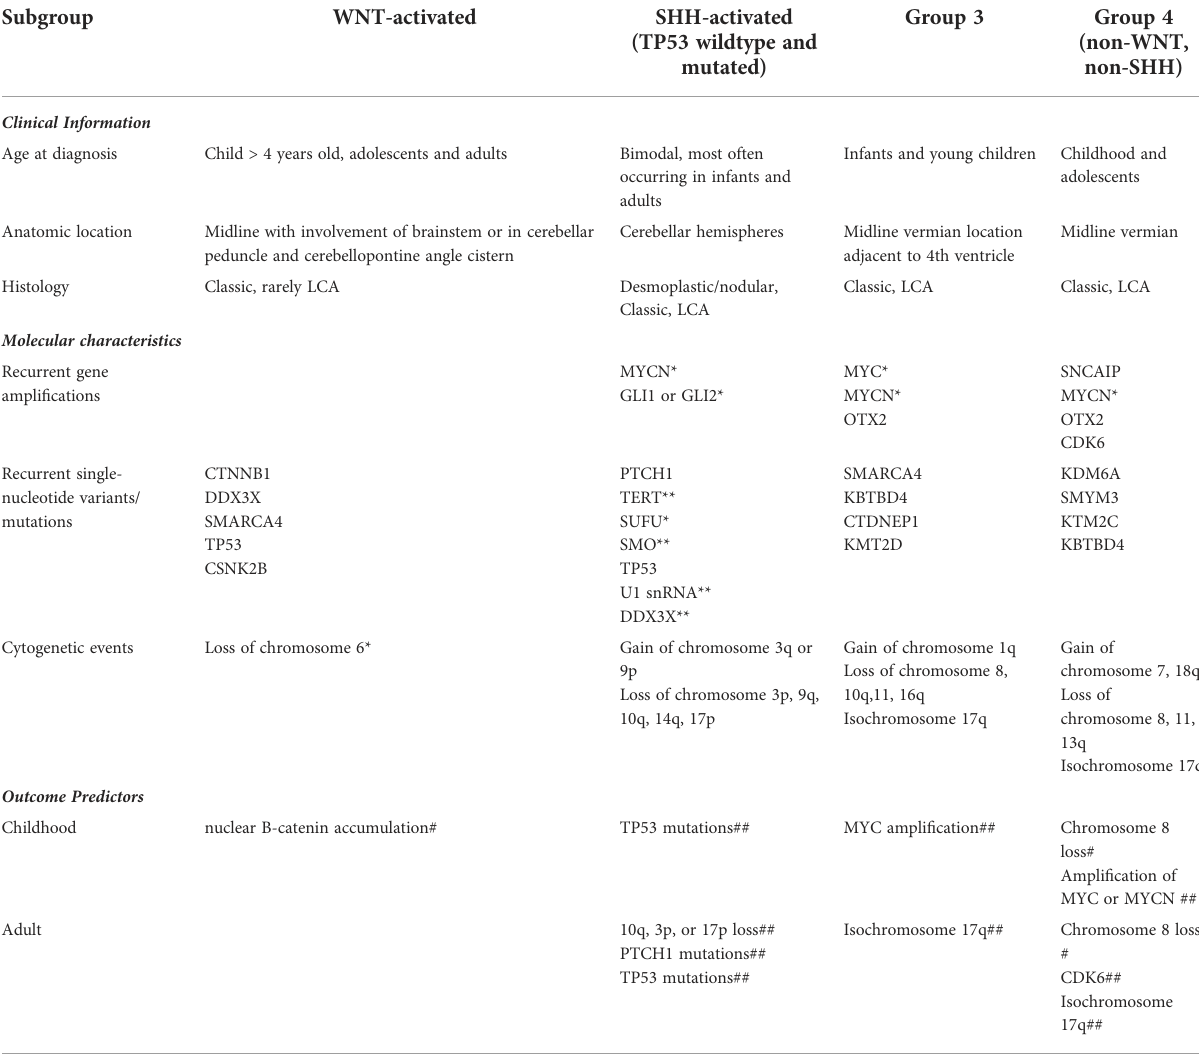
TABLE 2 Medulloblastoma subgroups with relevant clinical, molecular information and risk strati fi cation.